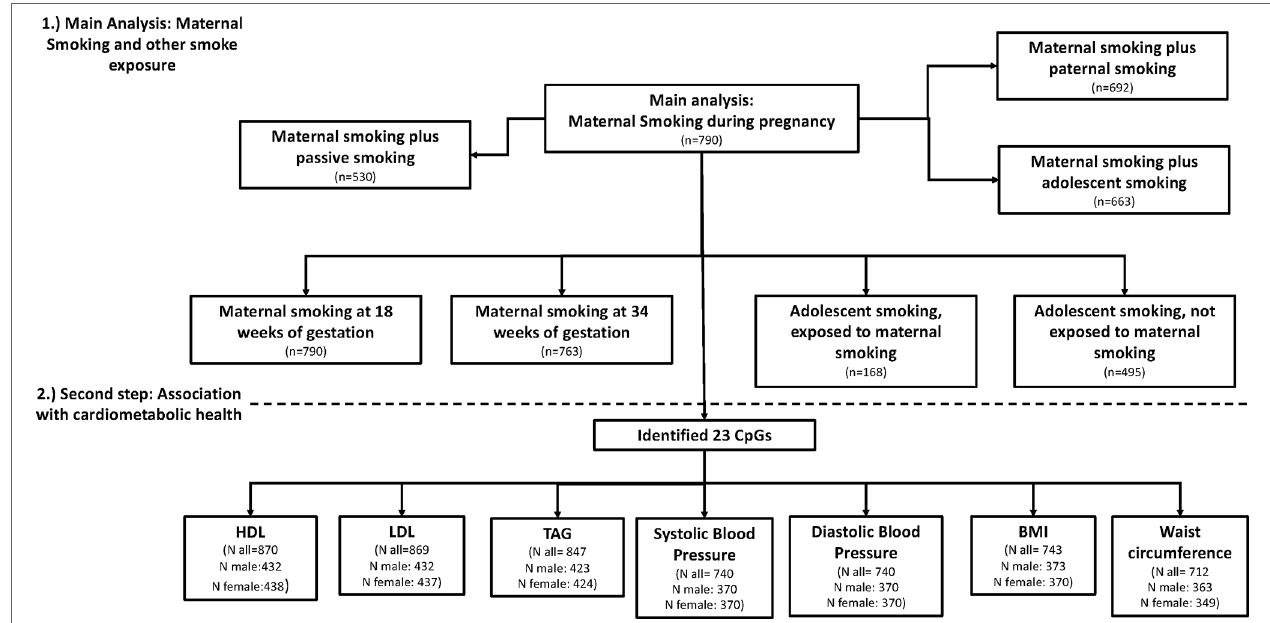
FIGURE 1 | Flow diagram of the analysis and sample size per